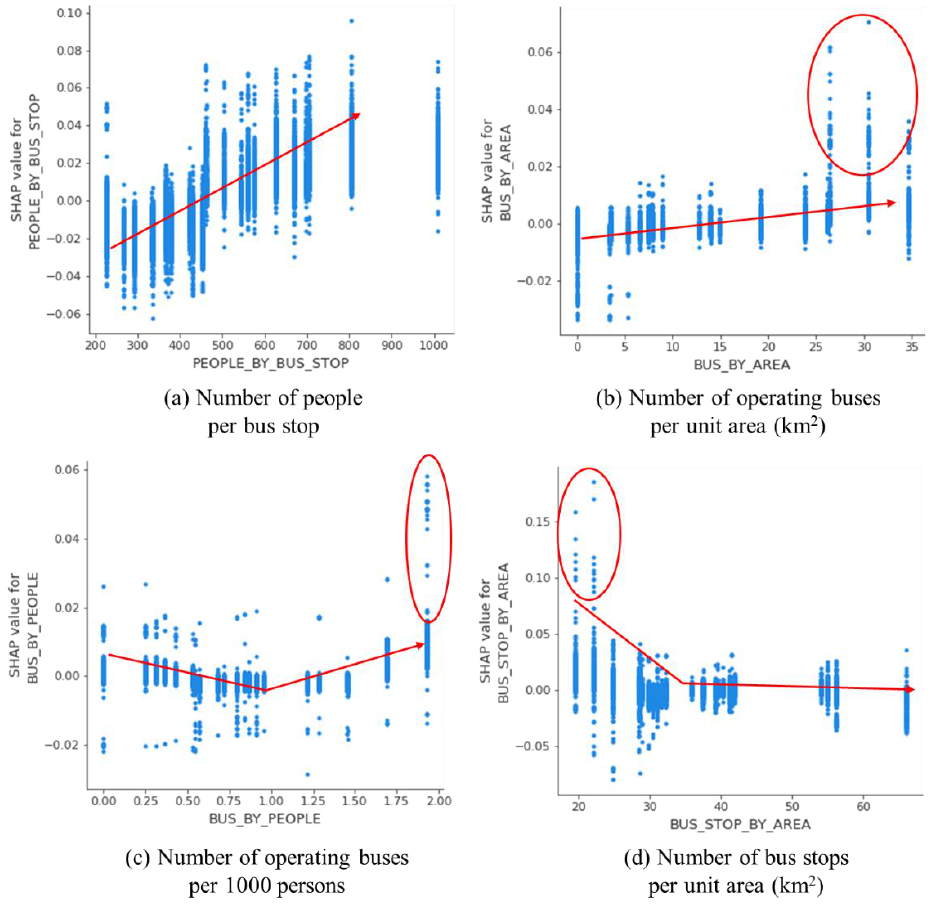
Figure 12. Dependence plots for features related to bus services.